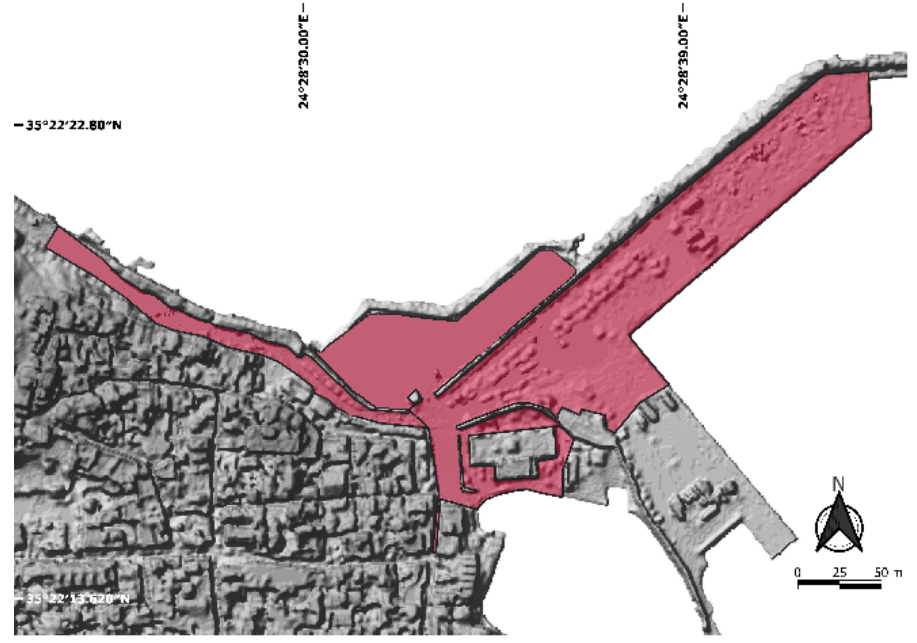
Figure 5. Maximum inundated area (highlighted with red color) from video recordings and local stakeholder observations.